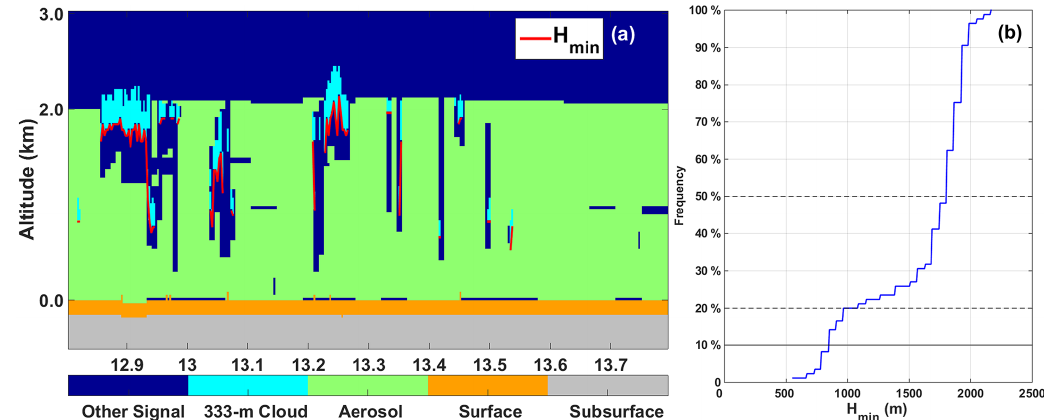
Figure 3. (a) The same as Fig. 2c but with the distribution of H min (the red line). (b) Cumulative distribution of the H min at any quantile for the scene in panel (a) (The black solid line represents the H min at the 10% quantile, which will be used to reduce the interference of strong surface signals and thick aerosols. The black dotted lines represent the H min at the 20% and 50% quantile,